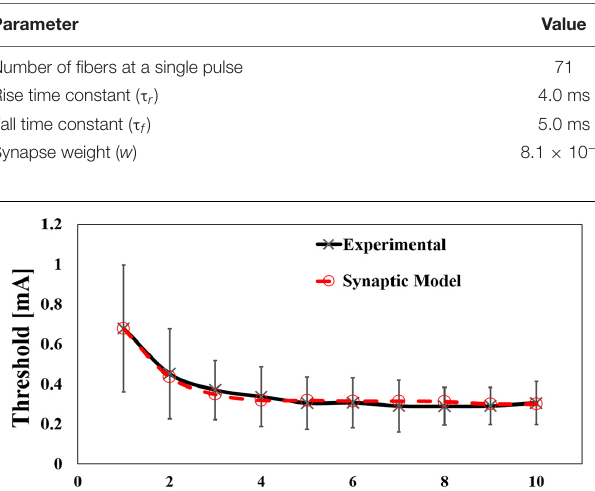
on the number of pulses and the frequency variation. We then proposed a computational model for synaptic